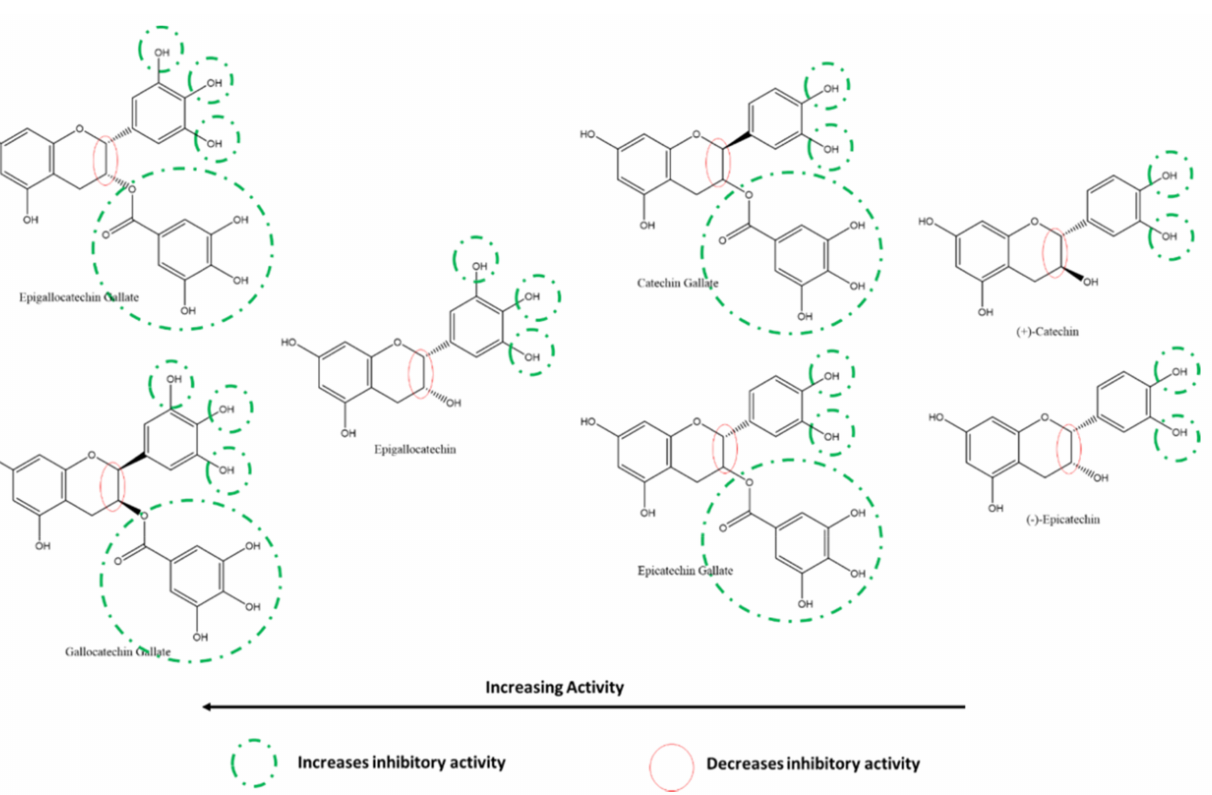
Figure 15. Structure–activity relationships of various flavan-3-ols against SARS-CoV-2 3CLpro, adapted from the experi- ments of [118]. Substitutions and groups that result in an increase/decrease in inhibitory activities are shown in red and green,